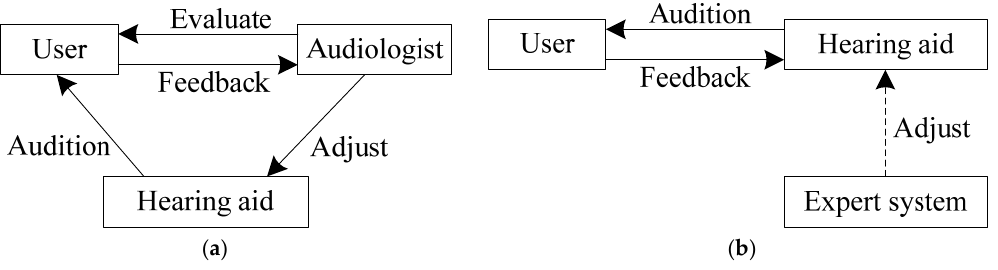
Figure 1. Different fitting processes for hearing aids. ( a ) Traditional fitting process; ( b ) Self-fitting process.